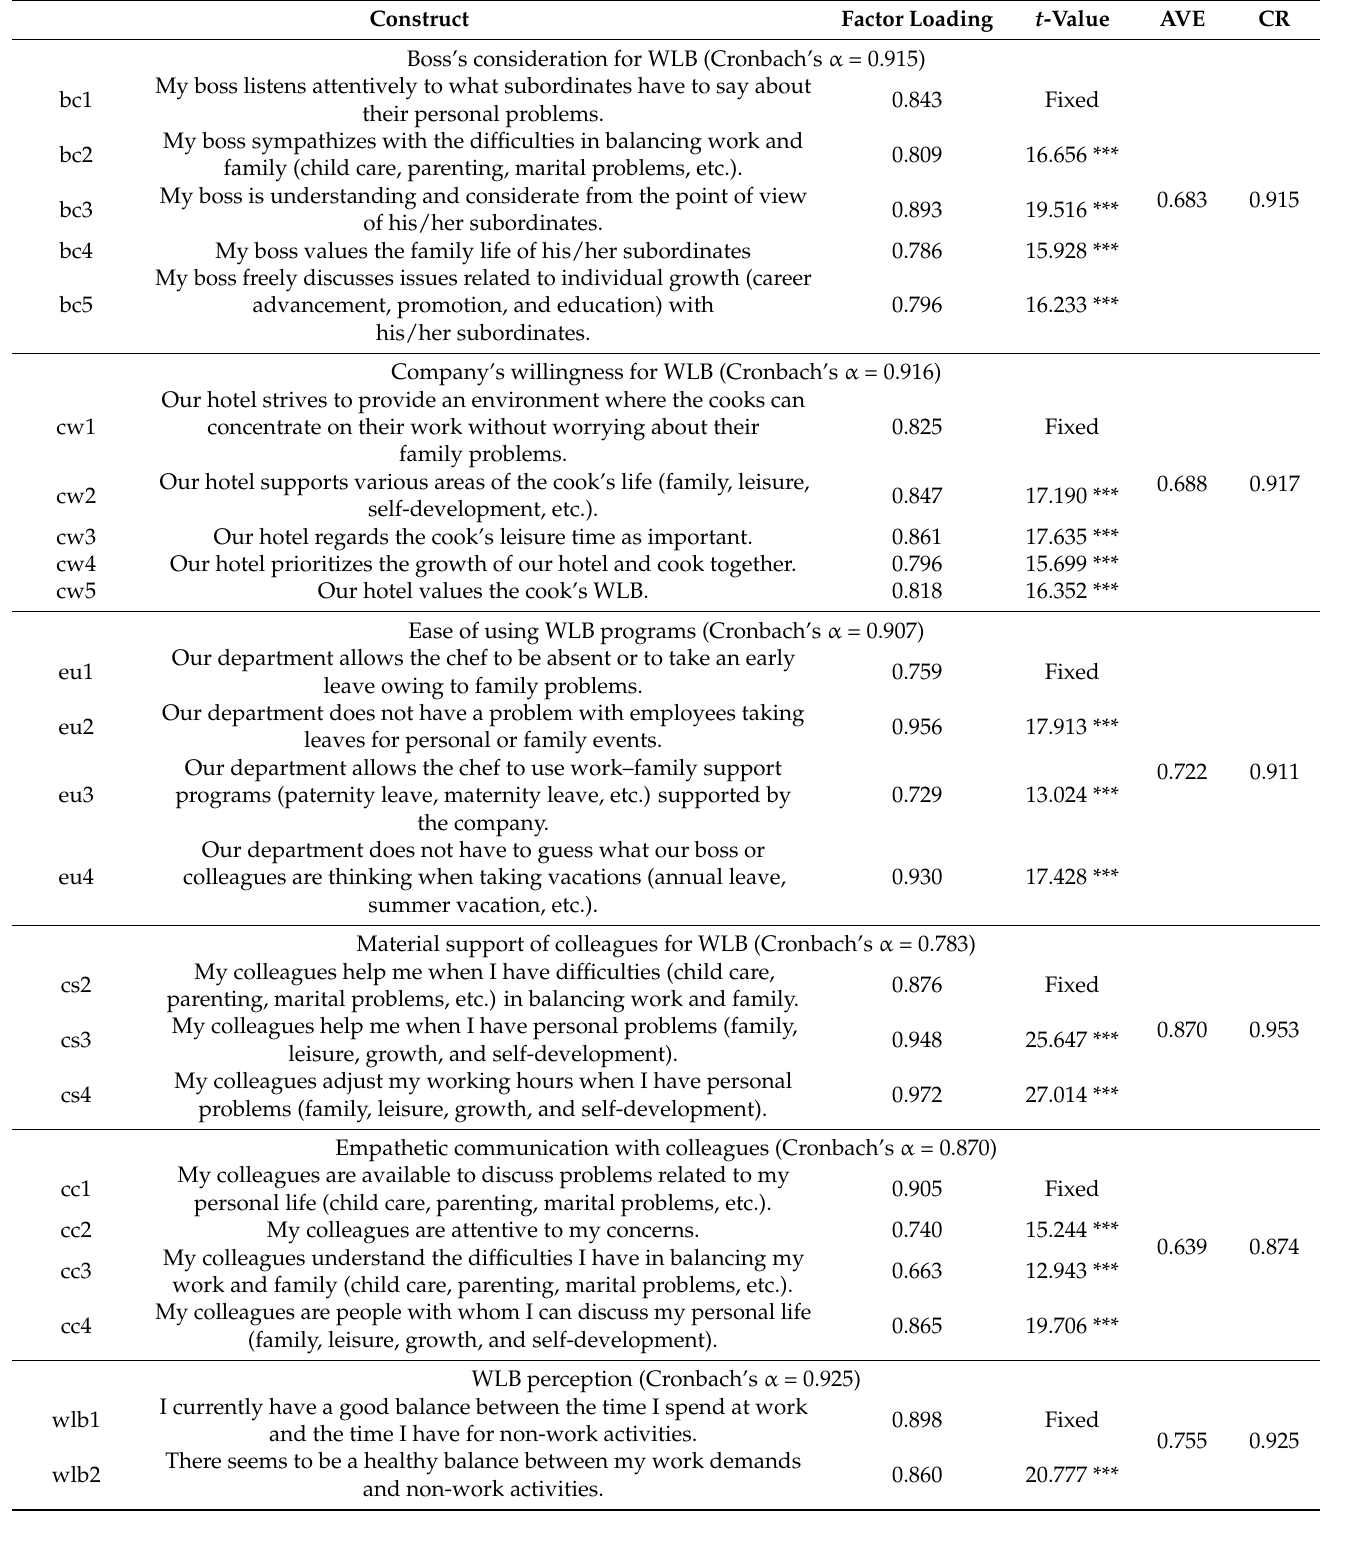
Table 2. Results of the confirmatory factor analysis and reliability analysis. Construct Factor Loading t -Value